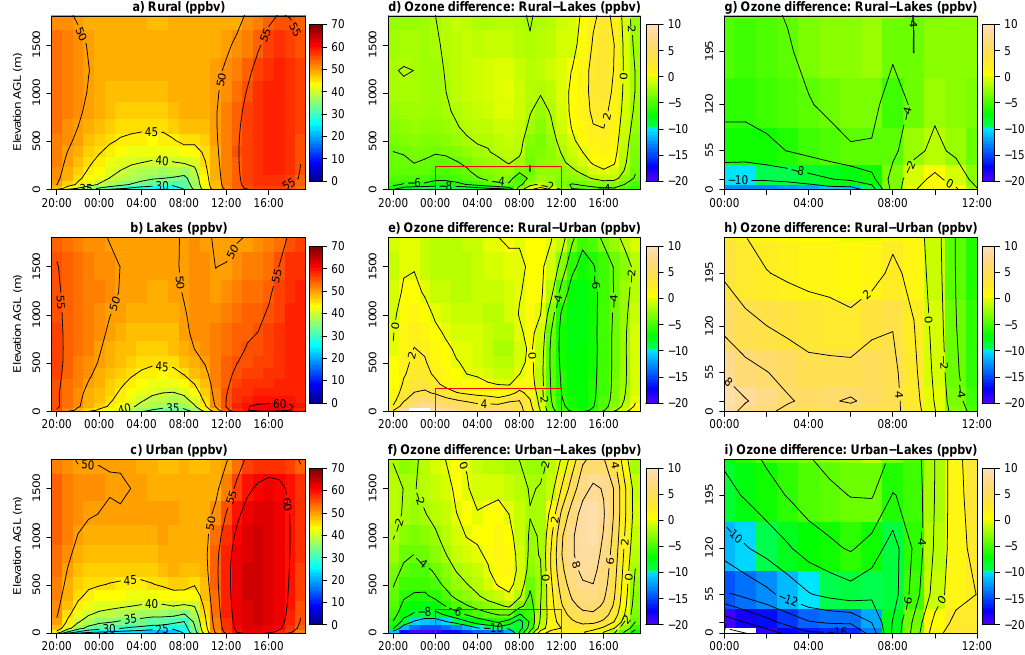
Fig. 3. Mean AURAMS model output showing time-height cross-sections for the sub-domain shown in Fig. 2, sorted by surface type: (a) rural; (b) lake; and (c) urban. Differences are shown between (d) rural and lake, (e) rural and urban, and (f) urban and lake surface types, with the red frames in the middle panels marking a higher-resolution cross-section for midnight-noon up to 240ma.g.l. shown in panels (g) , (h) and (i) ,